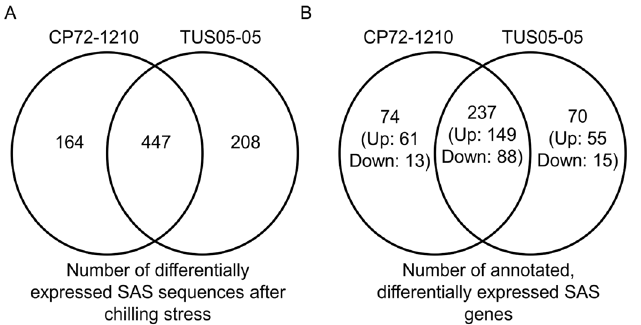
Fig 1. Venn diagram of differentially expressed genes in CP72-1210 and TUS05-05. A. Venn diagram of differentially expressed SAS sequences before gene annotation. B. Venn diagram of annotated genes differentially expressed in each genotype. The number of uniquely and commonly expressed genes in each genotype is indicated in numbers in the diagram. Up and Down indicate up-regulation and down- regulation,